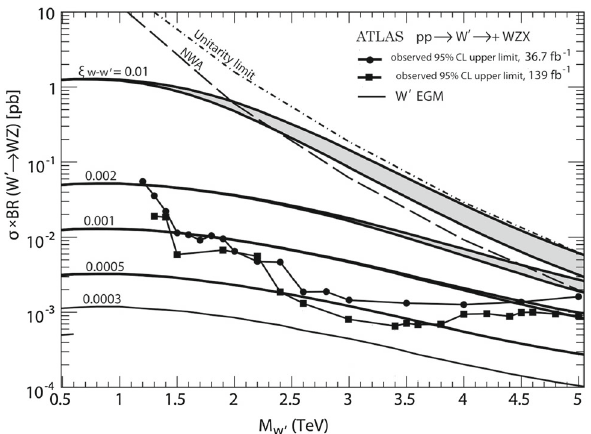
Fig. 4 95% CL exclusion regions in the two-dimensional ( M W (cid:2) , ξ W − W (cid:2) ) plane obtained from the precision electroweak data (horizon- tal dashed straight line labeled “EW”), the direct search constraints at the Tevatron in p ¯ p → W Z X (the dark shaded area) as well as from the LHC measurement of pp → W Z X at 7 TeV and 8 TeV (Run 1) (the gray area) and at 13 TeV from diboson W (cid:2) → W Z production in hadronic final states using the partial and full Run 2 ATLAS data set. Limits obtained from the semileptonic channel (cid:2)ν qq at time-integrated luminosityof36 . 1fb − 1 [40]areoverlaidforcomparison.Thecombined exclusion region for the EGM W (cid:2) boson obtained after incorporating direct search constraints from the LHC Run 2 data set is shown as the light shaded area. The uninarity limit is shown as a dot-dashed curve